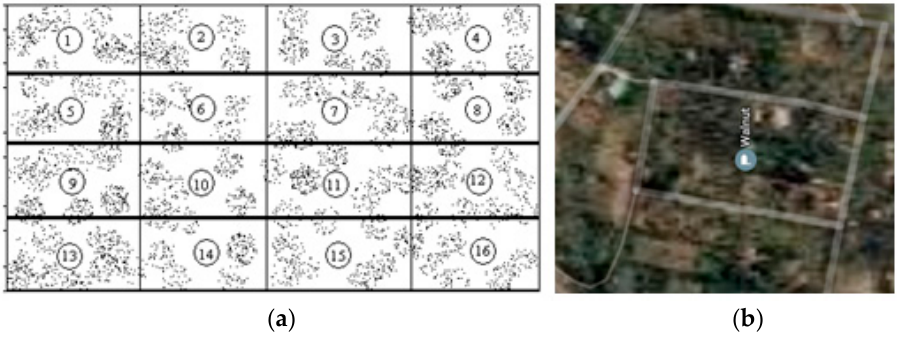
Figure 4. ( a ) Sensors placement in the land; ( b ) Sensors map in the irrigation system